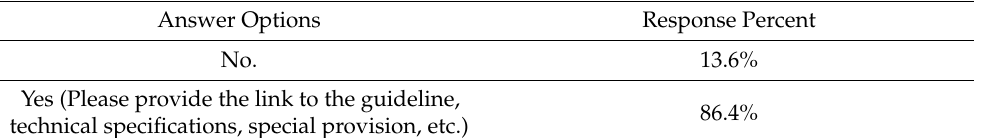
Table 14 reflects the availability of guidelines, technical specifications or special provi- sions to states which use GTR in asphalt mixes. From Table 14, it can be observed that 86% of the states which use GTR in asphalt mixes follow specific guidelines for this purpose. Table 14. Availability of guideline/specification/special provision to states incorporating GTR in HMA.